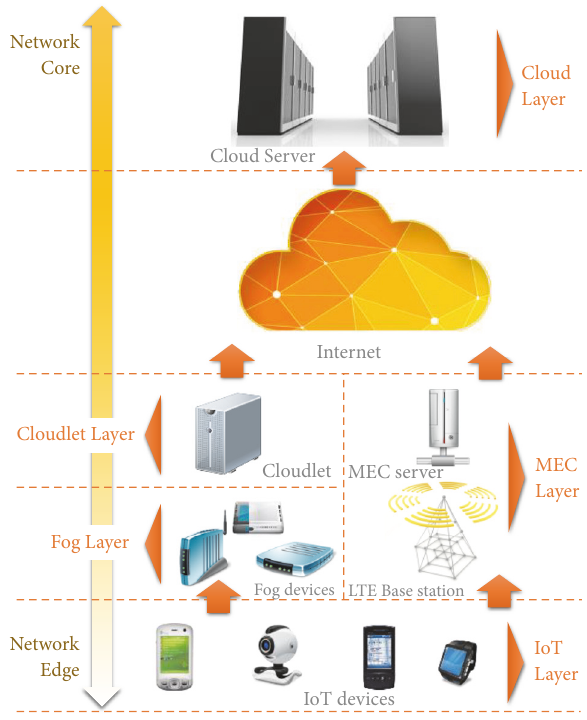
Figure 1: Outsourcing options deployed along the communication